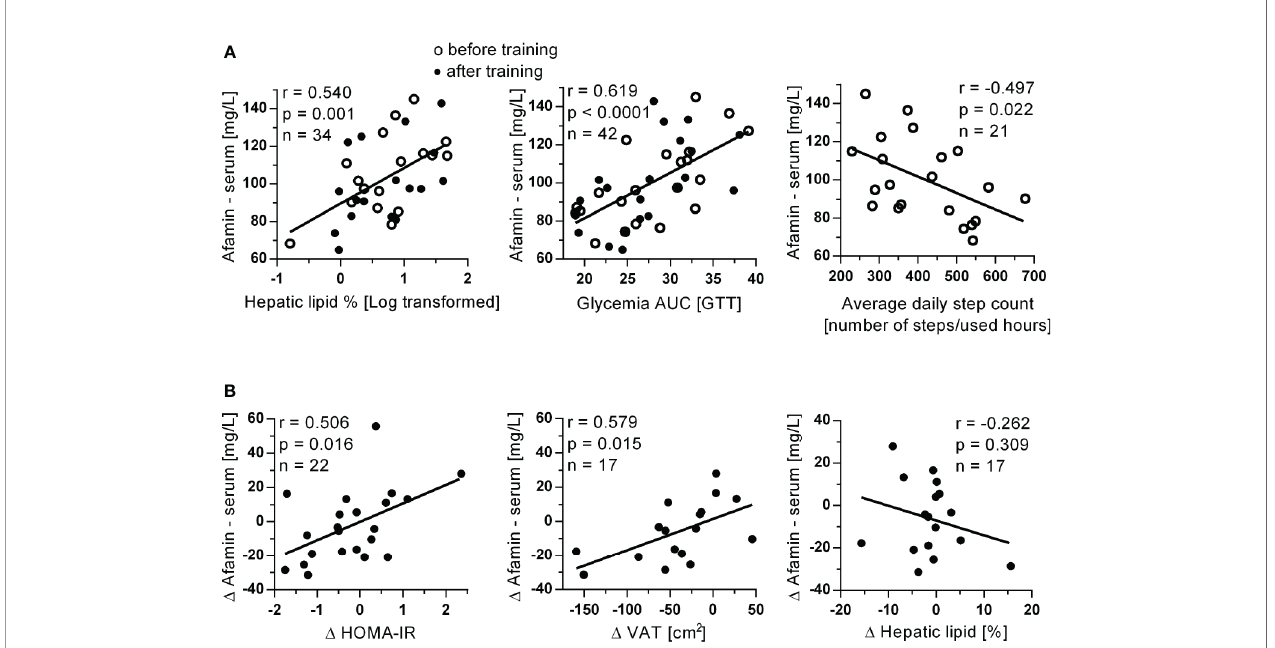
FIGURE 3 | Associations of (A) serum afamin concentrations with hepatic lipids, glycemia AUC and average daily steps count determined during the entire 12-week exercise intervention in study 2. Associations of (B) changes in serum afamin concentrations and changes in clinical parameters, induced by the 3-month exercise training intervention. D : value after training intervention (trained) – value before training (untrained); AUC, area under the curve; HOMA-IR, index of insulin resistance; oGTT, oral glucose tolerance test; VAT, visceral adipose tissue (assessed by MRI); Pearson linear